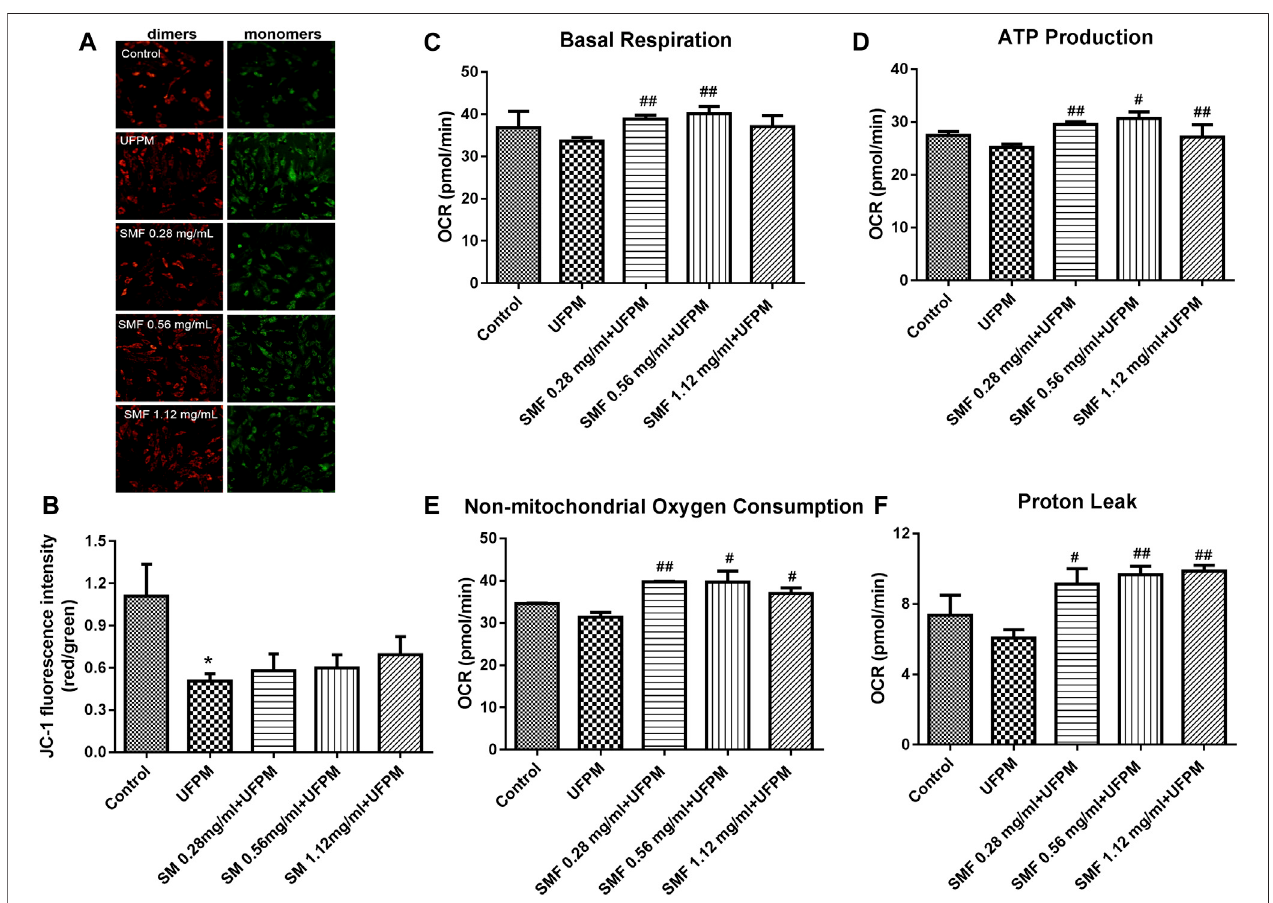
FIGURE 5 | SMF attenuated UFPM-induced mitochondrial damage in H9C2 cells. (A) Effects of the indicated concentrations of SMF on mitochondrial membrane potential in H9C2 cells. Representative images are shown. (B) The optical density ratio of the red and green fl uorescence is shown. * p < 0.05, compared to the control group. (C – F) SMF improves in vitro UFPM-induced mitochondrial activity. Basal respiration, ATP production, non-mitochondrial respiration, and proton leak of cells exposedtoUFPMwithorwithoutSMFpretreatment.Oxygenconsumption rate(OCR)wasmeasuredwithaSeahorsemetabolicanalyzer.Thedataarepresented as mean ± standard deviation (* p < 0.05, ** p < 0.01 compared to the control group; # p < 0.05, ## p < 0.01, ### p < 0.001 compared to the UFPM group). MI, myocardial ischemia; SMF, Shengmai formula; UFPM, ultra fi ne particulate